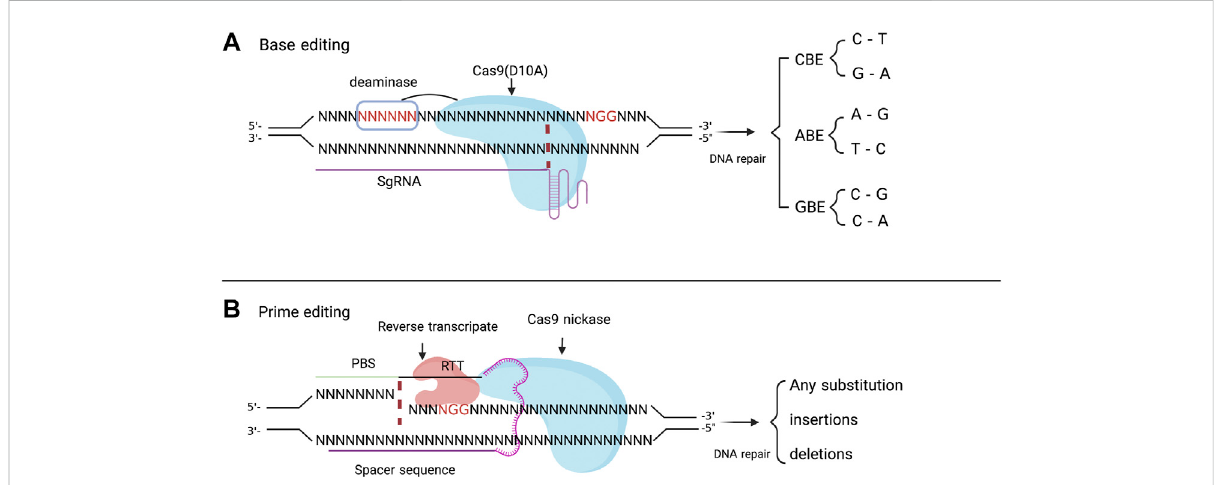
FIGURE 2 (A) represents a basic principle of base editor which is made of sgRNA that target a speci fi c DNA sequence, the Cas9 nickase (D10A) which in interactionwithsgRNAbindshisrecognitiondomain(PAMsequence)andcleavesthenon-PAMDNAstrand.TheCas9islinkedtoadeaminasewhich modi fi es the targeted nucleotide in a window of 5 nucleotides (shown in red color) in the spacer sequence through CBE, ABE, and GBE. The (B) depicts the prime editing principle makes of pegRNA which include a spacer sequence, a primer binding site (PBS) and reverse transcript template (RTT), and Cas9 nickase fused with a reverse transcriptase. The pegRNA recognizes the target sequence and provide the desired sequence formodi fi cation.OncetheCas9n cleavestheDNAsequence,thereversetranscriptaseusestheRTTastemplateforthesynthesis ofanewsequence containing the desired edit (gene substitution, insertion and